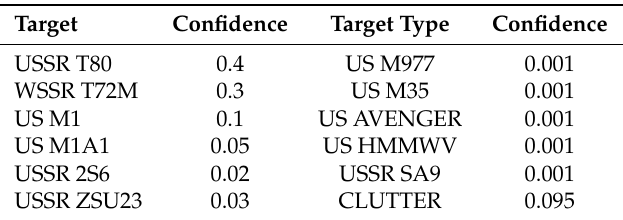
Table 1. An example of the body of a piece of